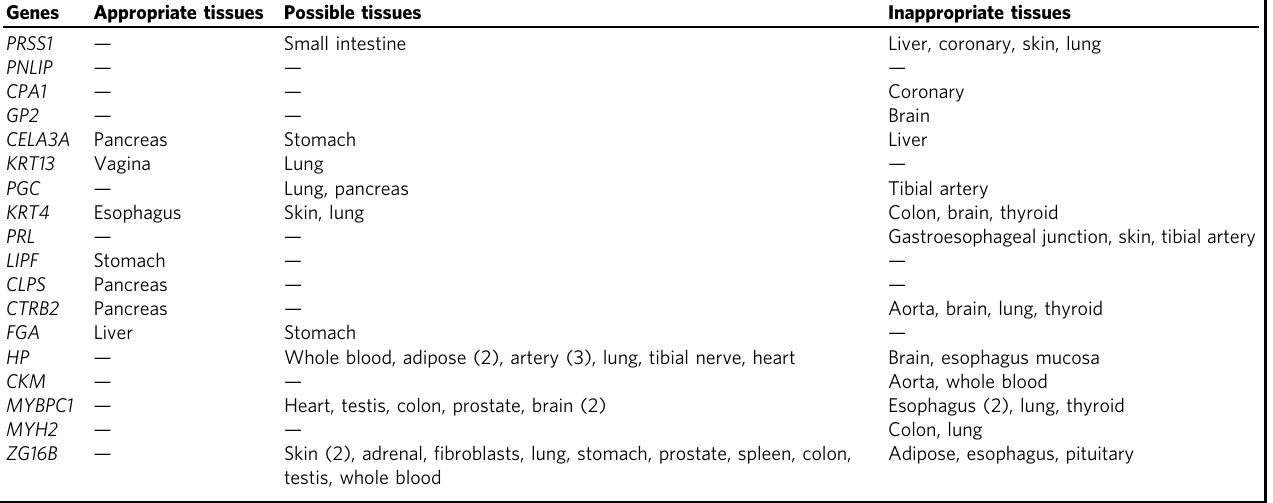
Table 4 Distribution of GTEx eQTLs by tissue type in contaminating genes. Genes Appropriate tissues Possible